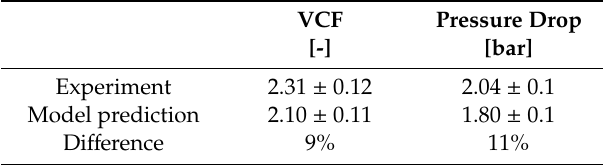
Table 5. Comparison of experimental and simulated process variables.